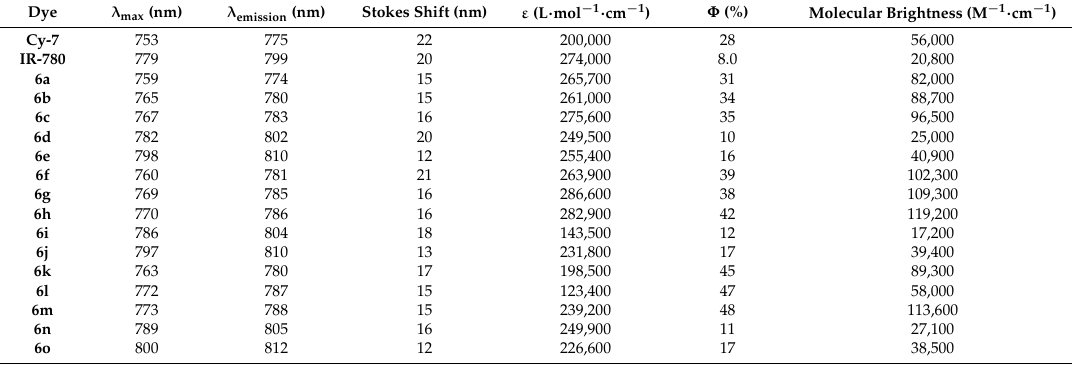
Table 1. Spectral Characteristics of dyes Cy-7 , IR-780 and 6a – o . All optical properties of the dyes were measured in ethanol.